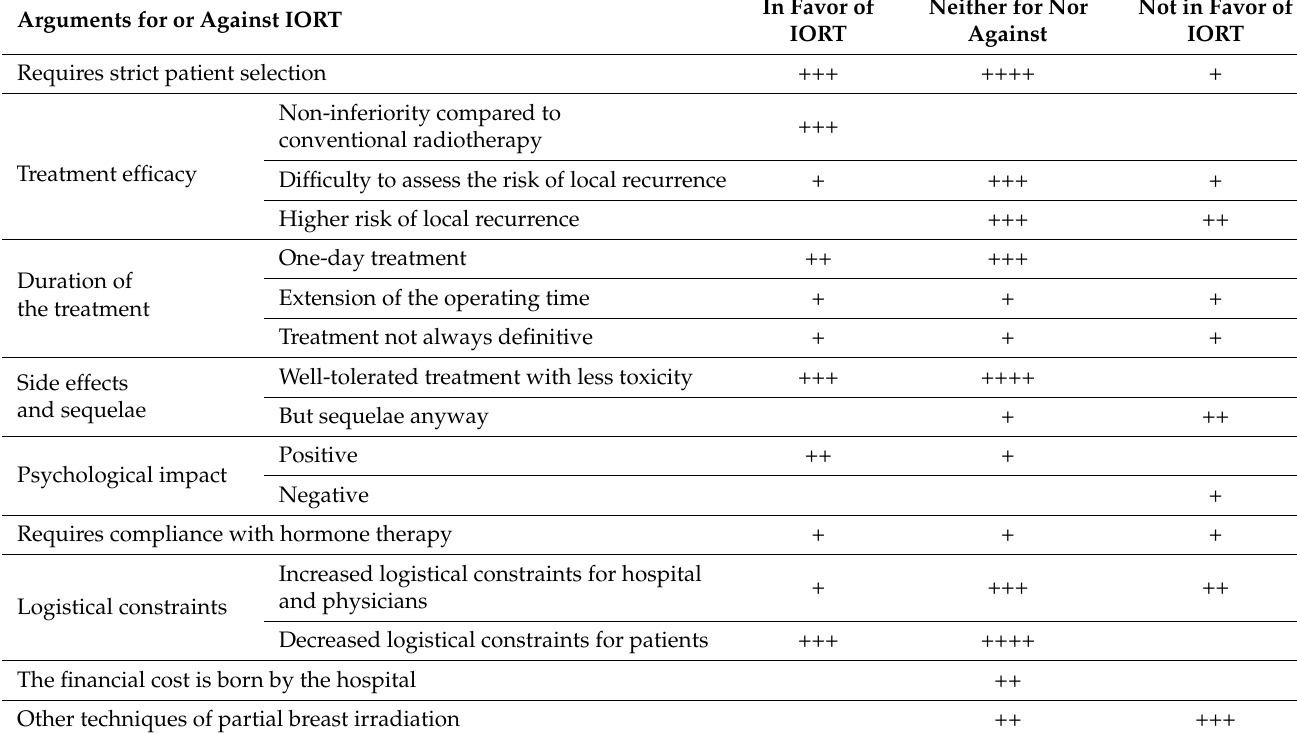
Table 2. Occurrence of the physicians’ arguments about